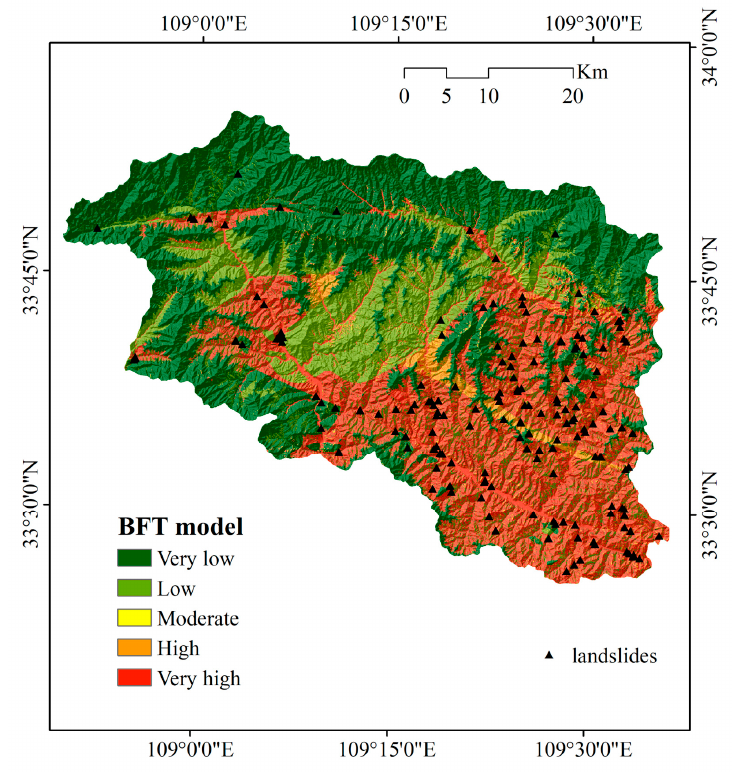
Figure 4. Landslide susceptibility map using the BFT model.